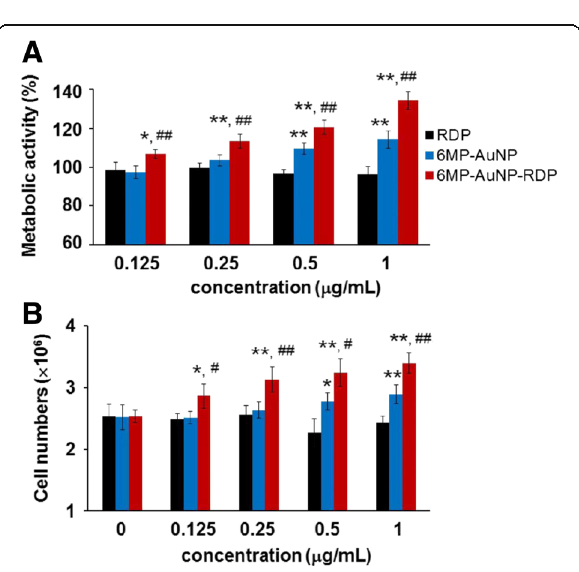
Fig. 4 The particles increased cell metabolic activity ( a ) and numbers ( b ), and concentration of 6MP-AuNPs and 6MP-AuNPs-RDP varied from 0 to 1.0 μ g/mL Data are presented as mean±SEM. The cells with only solvent {0.1 M NaOH (pH 9.0) is adjusted to pH 7.4 by 0.1 M HCl} were used as control. The values were averaged for four independent experiments. * p <0.05, ** p <0.01 compared with RDP-treated cells, # p <0.05,